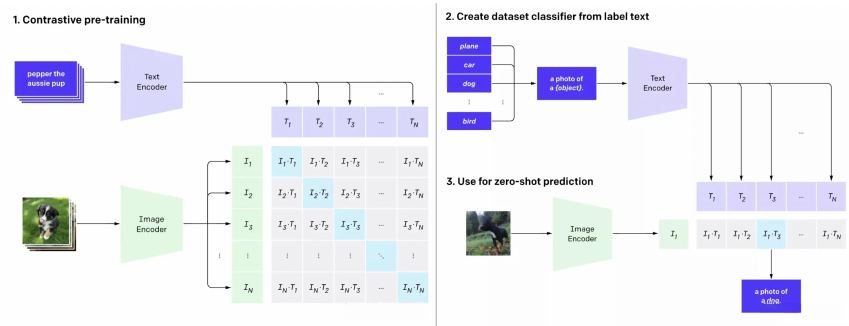
Figure 4. The schematic diagram of the principle of CLIP model.